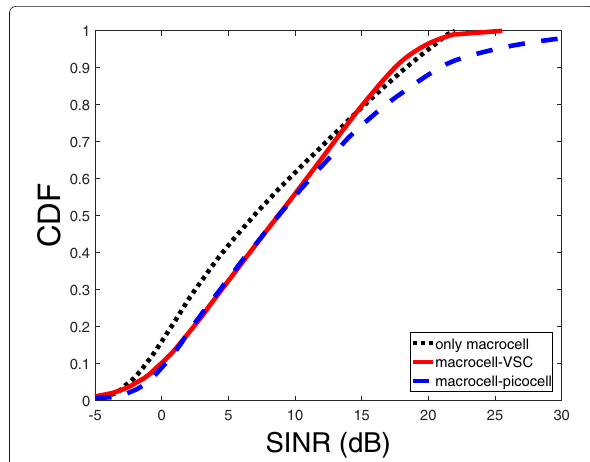
Fig. 5 SINR CDF at dense urban scenario [9]. This figure represents the SINRs of three scenarios, i.e., only macrocell, macrocell-VSC, and macrocell-picocell scenarios. Figure shows that SINR in the macrocell-VSC scheme follows the performance of the picocell scheme in 60% of the cases, and is as good as the only macrocell scheme for the rest while avoiding the deployment cost of